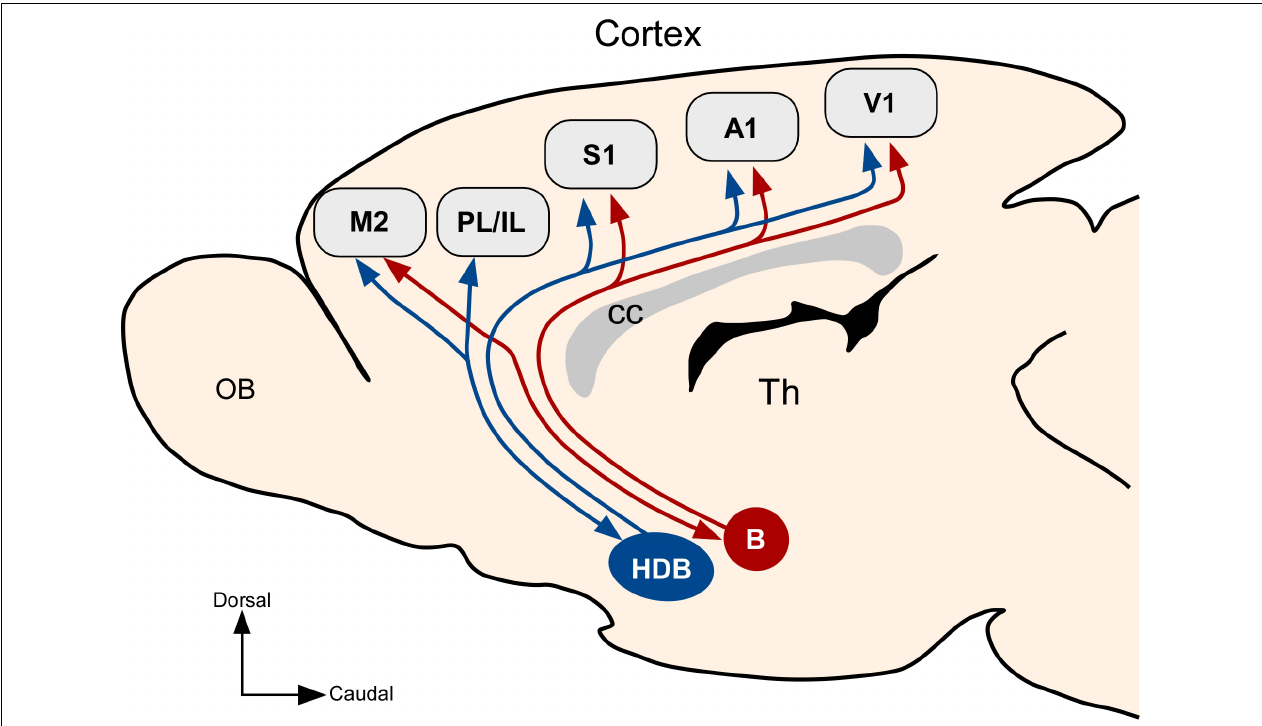
FIGURE 11 | Summary diagram displaying anatomical connections of HDB and B nuclei. Results showed that HDB has preferential projections to sensory cortices and PL/IL cortices while the B nucleus projects to all sensory areas in general and does not project to PL/IL cortices but it projects to M2